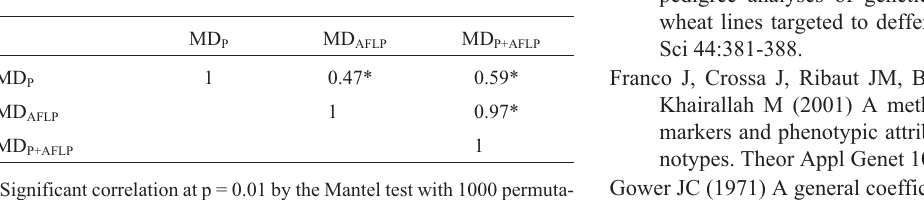
Table 4 - Correlation between genetic distance matrices estimated through the analyses of phenotypic characters (MD P ), amplified fragment length polymorphism (AFLP) markers (MD AFLP ) and combined analysis (MD P+AFLP ) for 19 wheat